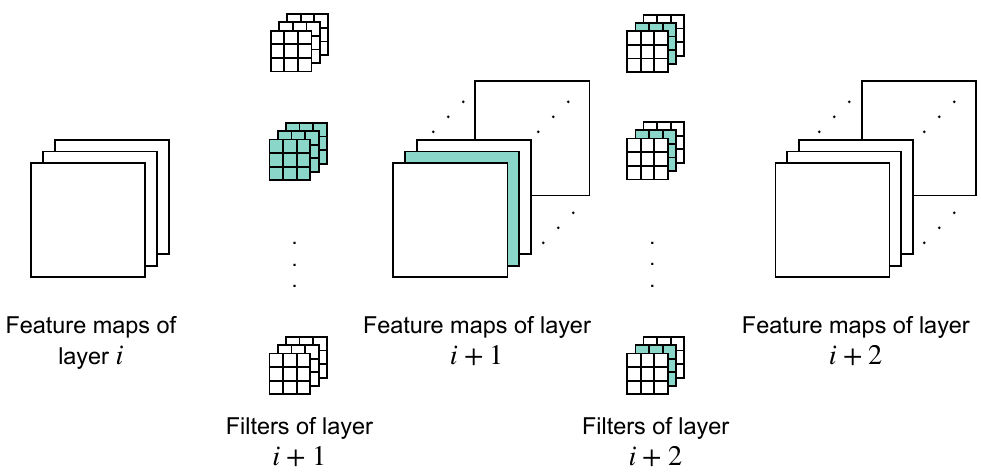
Figure 7. Filters containing zeroes can be removed from the model. By doing so, the corresponding feature maps, as well as their corresponding channel in the next layer, have to be removed.